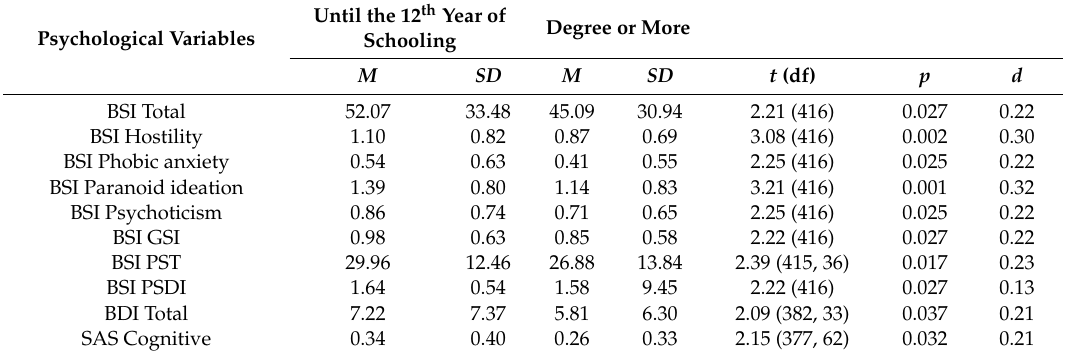
Table 7. Significant means di ff erences of education.